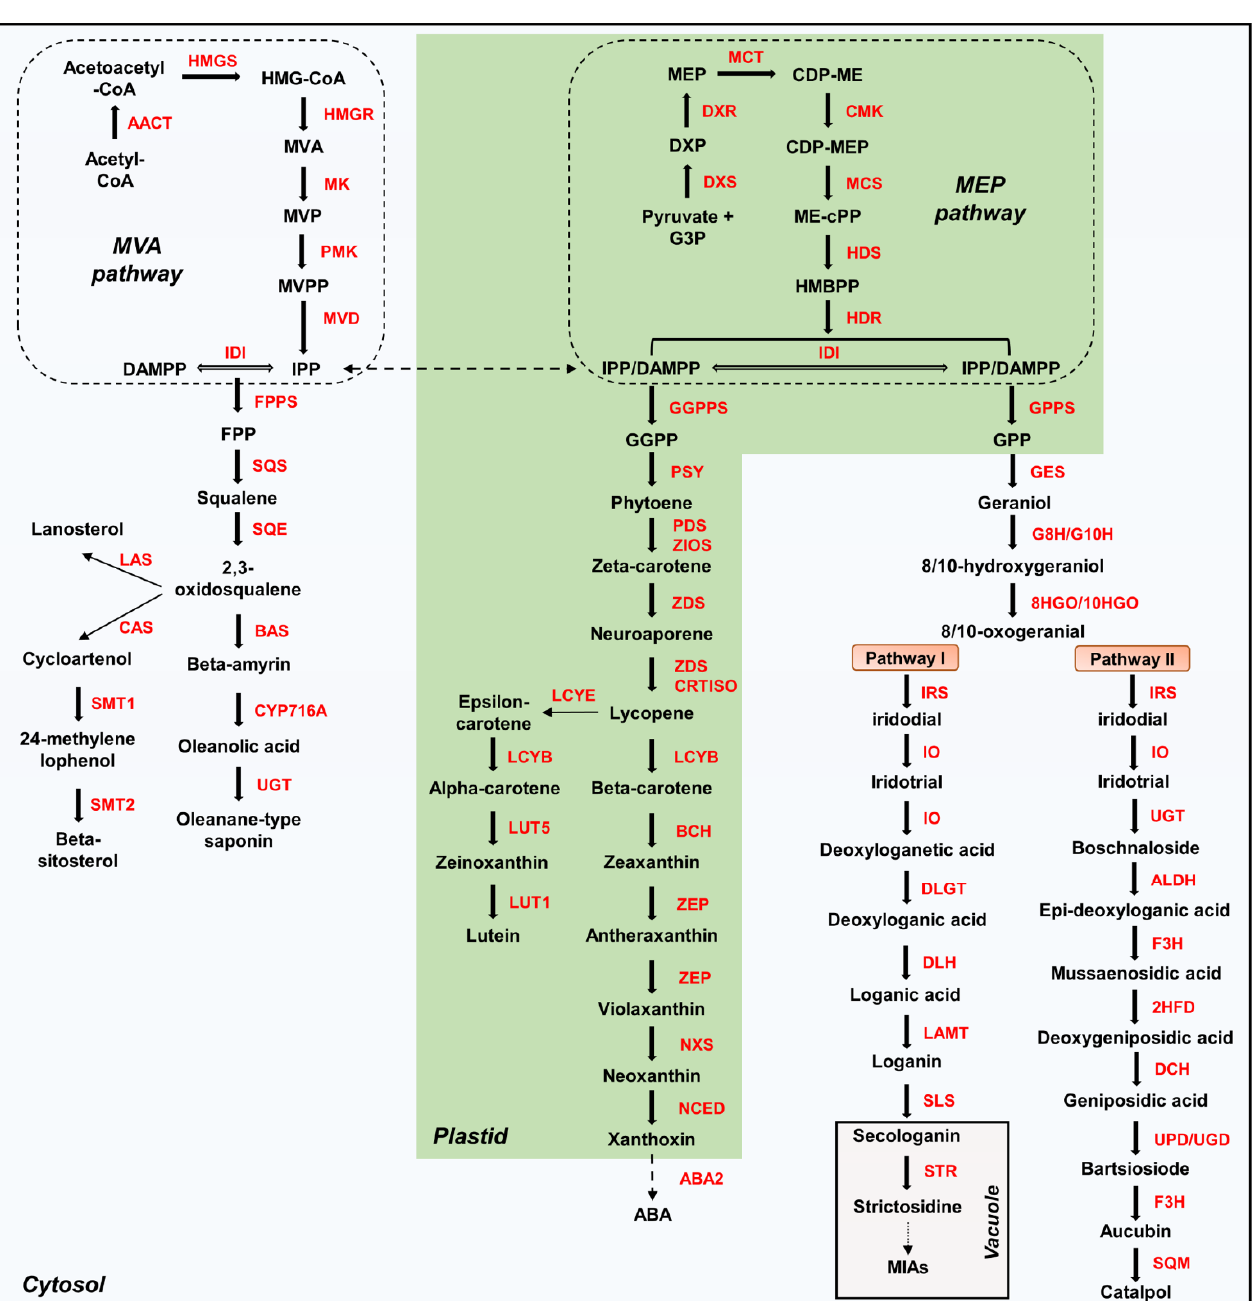
Figure 1. Terpenoid metabolism in plants. HMG , 3 ‐ hydroxy ‐ 3 ‐ methylglutaryl; MVA , mevalonate; MVP , mevalonate phosphate; MVPP, mevalonate diphosphate; IPP , isopentenyl pyrophosphate; DAMPP , dimethylallyl pyrophosphate; G3P , glyceraldehyde 3 ‐ phosphate; DXP , 1 ‐ deoxy ‐ D ‐ xylu ‐ lose 5 ‐ phosphate; MEP , methylerythritol 4 ‐ phosphate; CDP ‐ ME , 4 ‐ (cytidine 5 ′‐ diphospho) ‐ 2 ‐ C ‐ me ‐ thyl ‐ D ‐ erythritol; ME ‐ cPP , 2 ‐ C ‐ methyl ‐ D ‐ erythritol ‐ 2,4 ‐ cyclodiphosphate; HMBPP , 1 ‐ hydroxyl ‐ 2 ‐ methyl ‐ 2 ‐ butenyl ‐ 4 diphosphate; FPP , farnesyl diphosphate; GGPP , geranylgeranyl diphosphate; GPP , geranyl diphosphate; TIAs , terpenoid indole alkaloids; ABA , abscisic acid; AACT , acetyl ‐ CoA acetyltransferase; HMGS , hydroxymethylglutaryl ‐ CoA synthase; HMGR , 3 ‐ hydroxy ‐ 3 ‐ methylglu ‐ taryl ‐ CoA reductase; MK , mevalonate kinase; PMK , phosphomevalonate kinase; MVD , mevalonate diphosphate decarboxylase; DXS , 1 ‐ deoxy ‐ D ‐ xylulose 5 ‐ phosphate synthase; DXR , 1 ‐ deoxy ‐ D ‐ xylulose 5 ‐ phosphate reductoisomerase; MCT , 2 ‐ C ‐ methyl ‐ D ‐ erythritol 4 ‐ phosphate cytidylyltrans ‐ ferase; CMK , 4 ‐ diphosphocytidyl ‐ 2 ‐ c ‐ methyl ‐ d ‐ erythritol kinase; MCS , 2 ‐ C ‐ methyl ‐ D ‐ erythritol 2,4 ‐ cyclodiphosphate synthase; HDS , 4 ‐ hydroxy ‐ 3 ‐ methylbut ‐ 2 ‐ enyl diphosphate synthase; HDR , 4 ‐ hydroxy ‐ 3 ‐ methylbut ‐ 2 ‐ enyl diphosphate reductase; IDI , isopentenyl ‐ diphosphate delta ‐